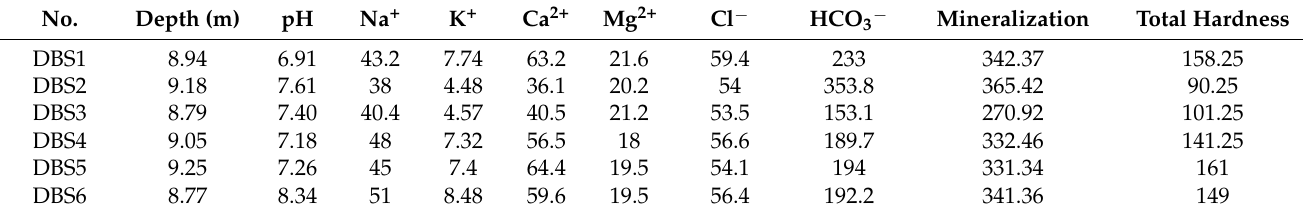
Table 2. Surface water quality analysis results (Unit: